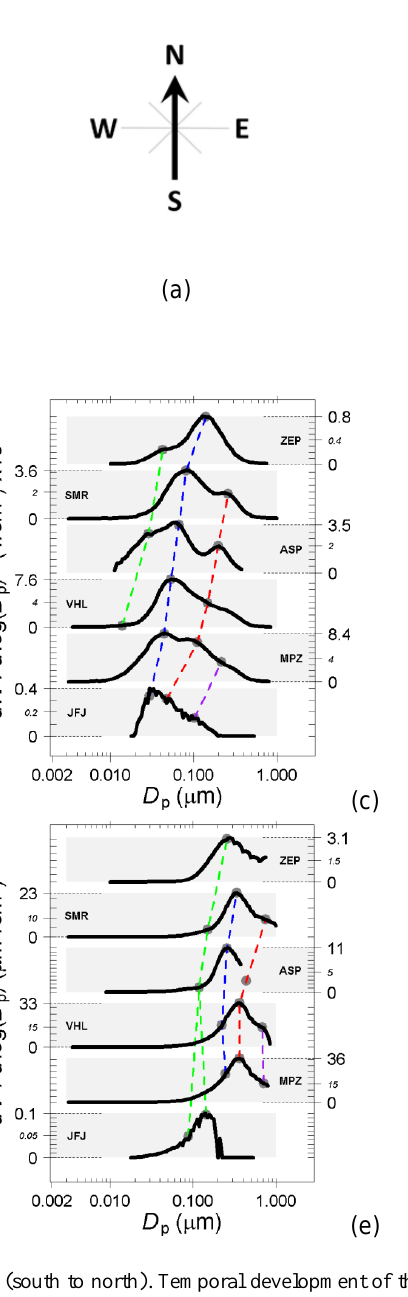
Fig. 10. Case study 3 (south to north). Temporal development of the particle size spectra plotted along the 5-day back-trajectory shown in plotted green/red from midnight to midnight on the particle number (PN) emission map shown in (b) , starting at JFJ-HPB on 2 February 2008 and arriving at ZEP on the 7 February 2008 at 06:00. Spectra collected from the nearest site to the air mass path are plotted in (c, e) . The peak fitted the modal diameters and area of each of these curves is shown in (d, f) . The middle panels correspond to the metrics derived from the number spectra and the lower panels correspond to the metrics derived from the volume spectra. The dotted lines in (c) and (e) are primarily to guide the eye, rather than being proposed as a firm causal